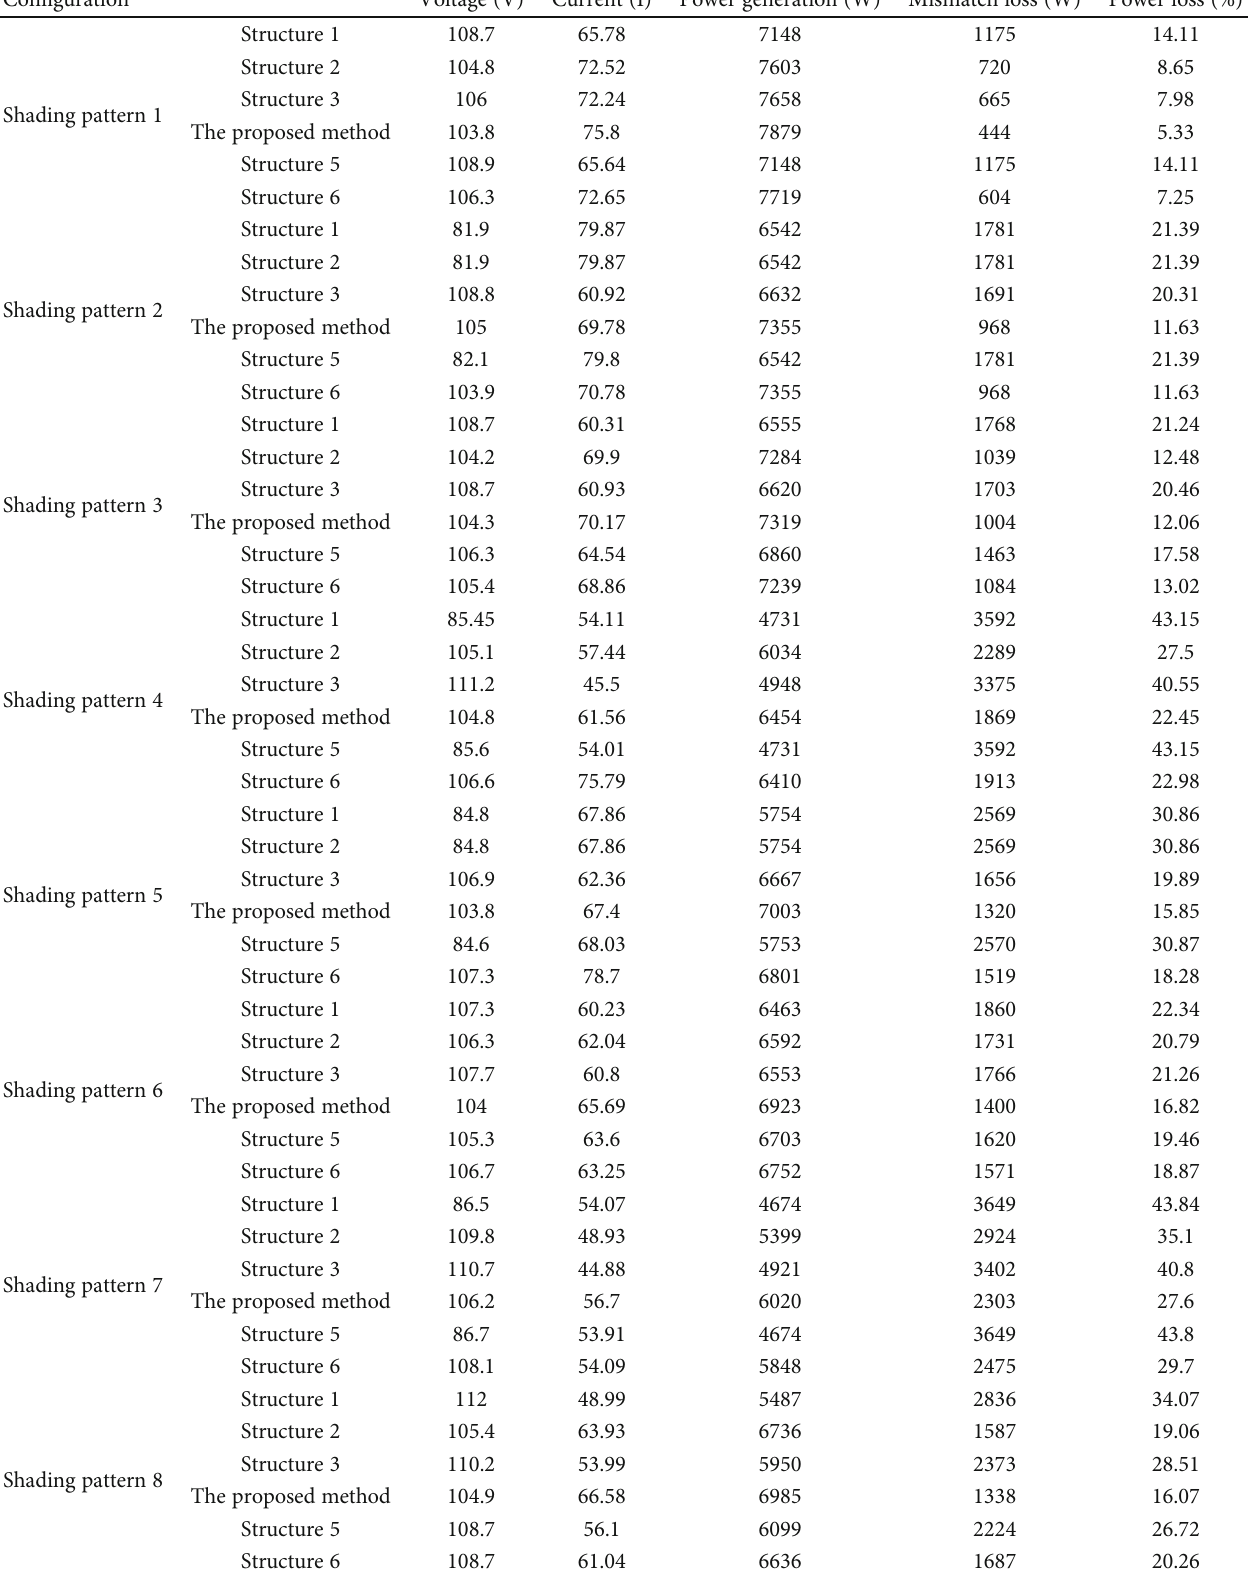
Table 3: Estimation of performance indices for shading patterns 1 –